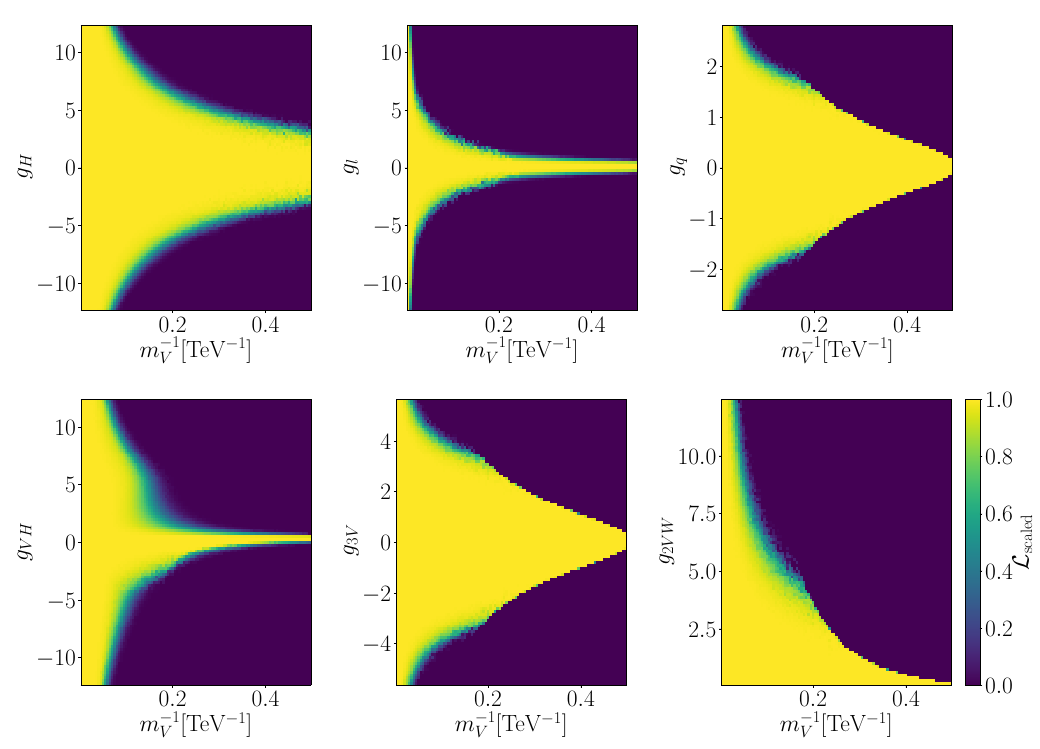
Figure 1: Decoupling pattern for the vector triplet model. Global fit with all